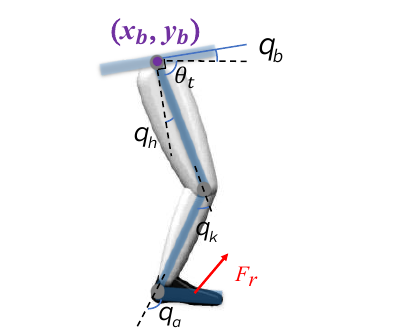
Figure 1. The control framework of intelligent lower-limb prosthesis. The blue parts are the high-level and mid-level controller, which aims at human intention recognition and joint trajectory planning. The purple parts are the main research subjects in this paper.